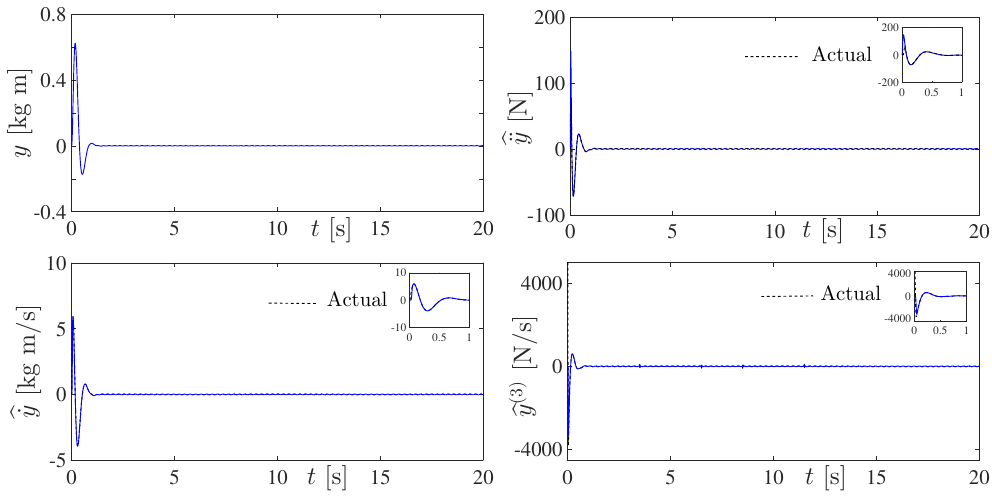
Figure 10. Online reconstruction of time derivatives of the flat output